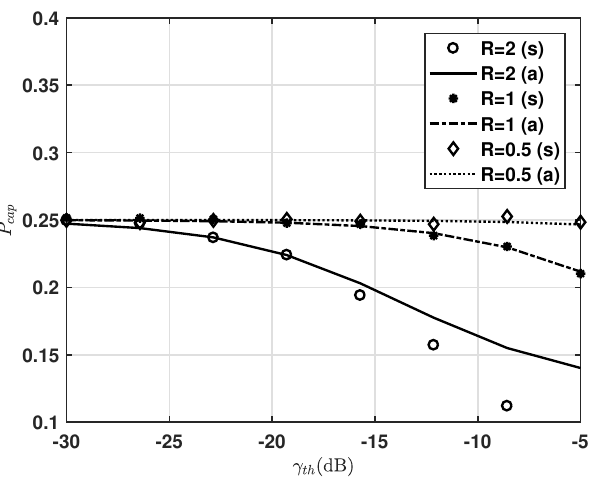
Figure 4. Capture effect probability vs. γ th and R